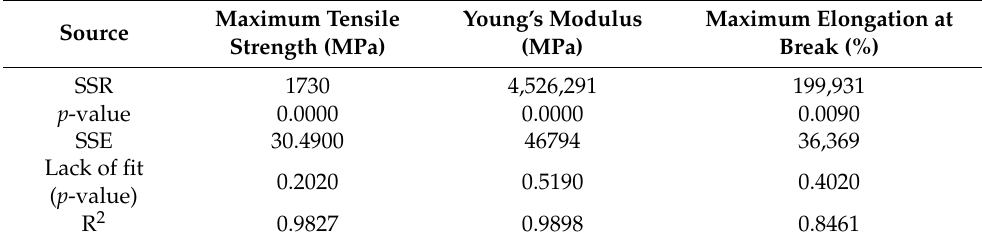
Table 2. Analysis of variance of mechanical properties in central composite design.